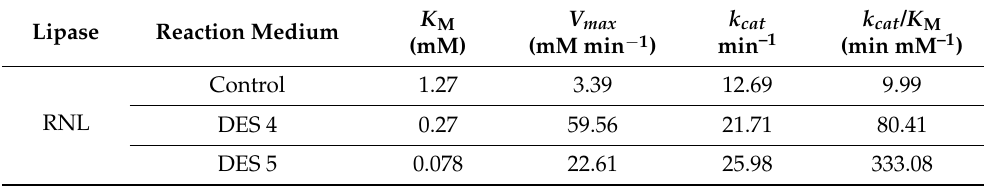
Table 4. Lipase kinetic parameters when hydrophobic DESs are present.